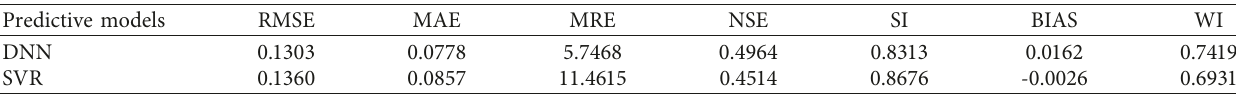
Table 2: The numerical evaluation indicators for the DNN and SVR predictive models “stand-alone versions” over the testing modeling phase.